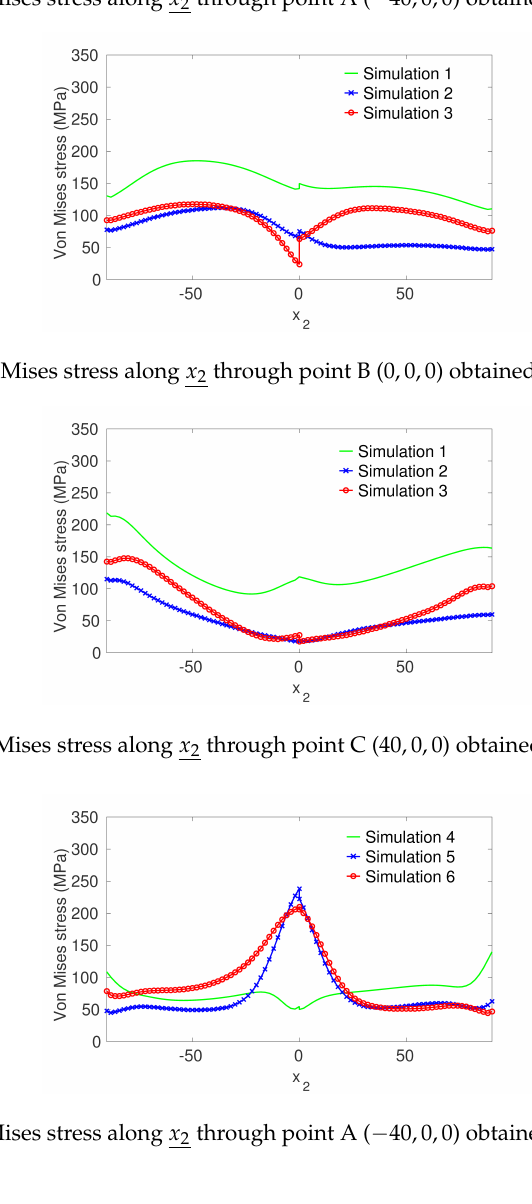
Figure 6. Profiles of Von Mises stress along x 2 through point A ( − 40,0,0) obtained by FE simulations 1, 2 and 3.